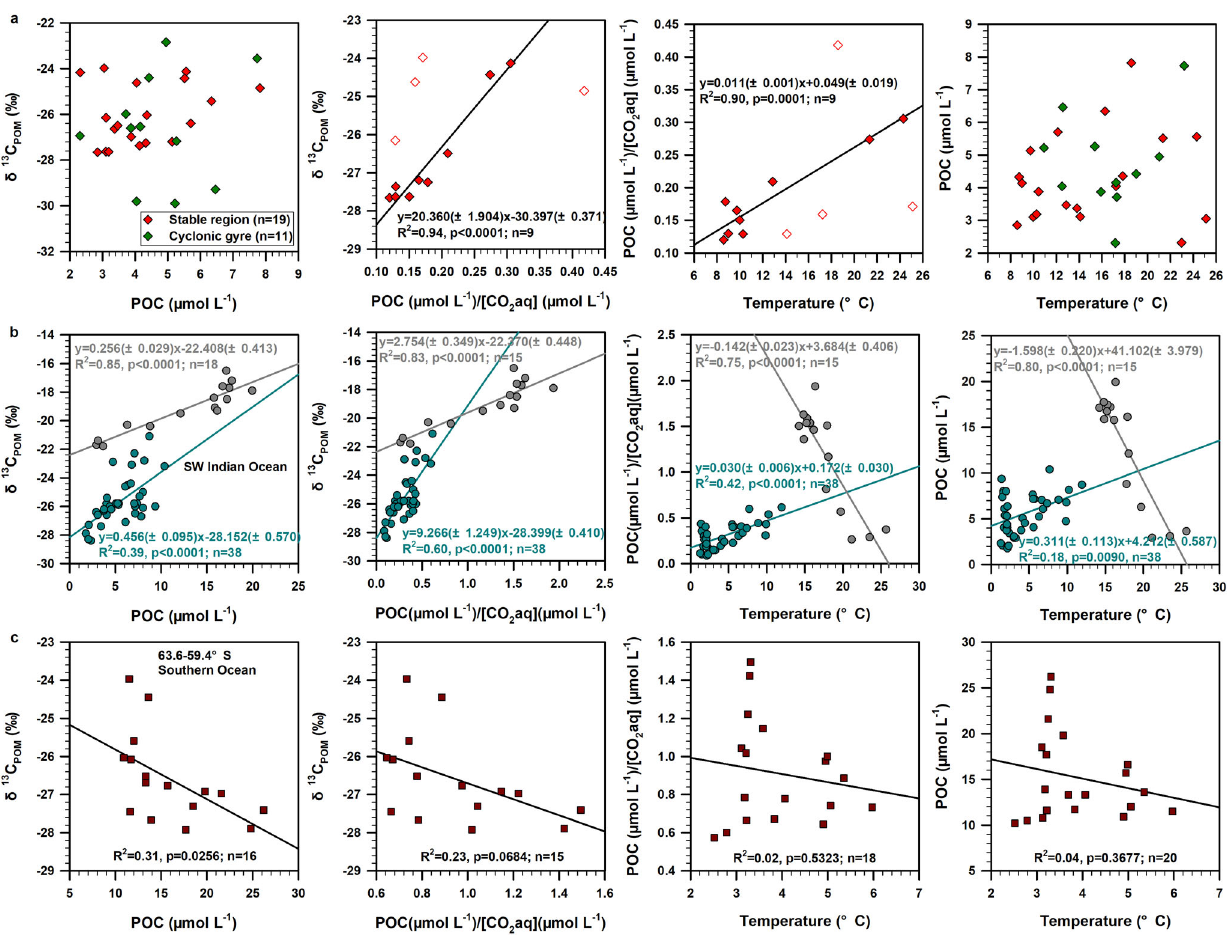
Fig. 4 Mechanisms of temperature-dependent δ 13 C POM . a Correlation of δ 13 C POM vs. POC concentrations and [CO 2 aq]-normalized POC, a proxy variable for carbon (C) demand/supply ratios, as well as [CO 2 aq]-normalized POC vs. temperature, POC vs. temperature in the DCM of SYS. Due to the small number of [CO 2 aq] data available, the speci fi c relationship of δ 13 C POM and temperature with POC/[CO 2 aq] is not evaluated in the cyclonic gyre of SYS. b , c Same plots for POM in the surface water of SW Indian Ocean and Southern Ocean for comparison; data in b , c are derived from Francois et al. 93 and Kennedy and Robertson 94 , respectively. Open squares in a were not included in the regression. The numbers within parentheses of the fi tted equation represent standard